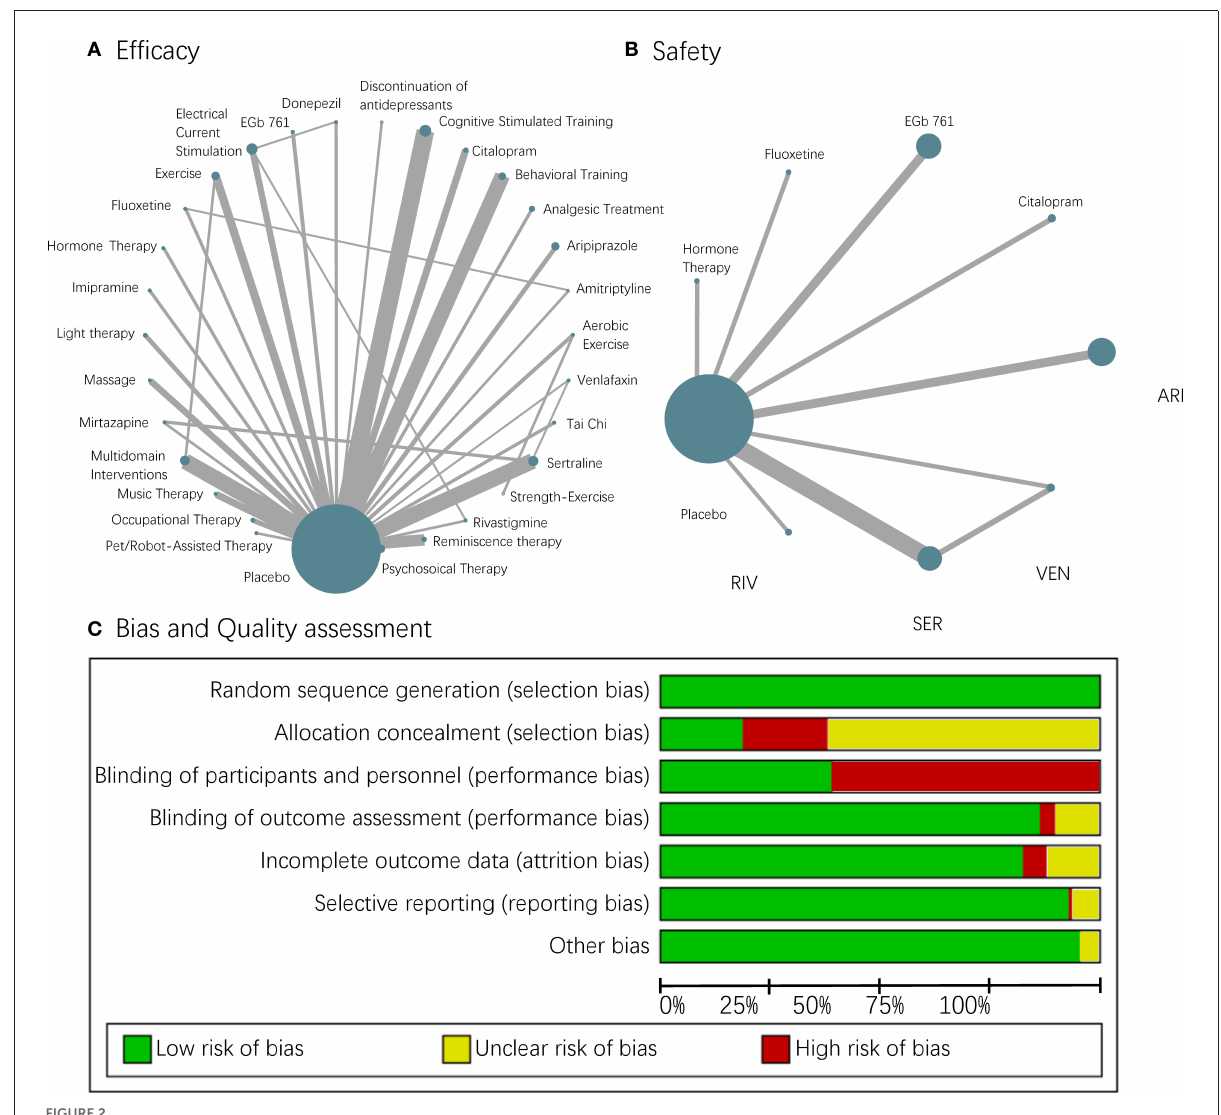
FIGURE2 A network plot and risk of bias. (A,B) Each node in the network geometry represents a kind of intervention. Nodes will be linked by a line when the treatments are directly comparable with “head-to-head trails.” The size of the nodes corresponds to the number of participants receiving that intervention, and the width of the lines is proportional to the number of RCTs this comparison included. (C) Risk of bias chart of studies included in the quantitative